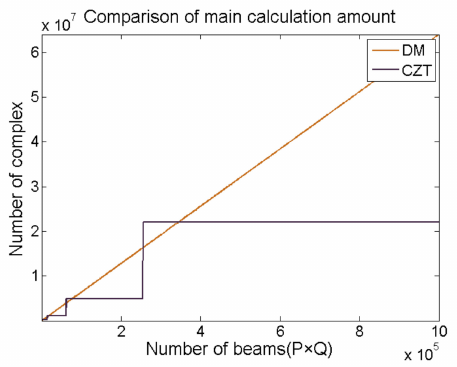
Figure 3. Comparison of main calculation